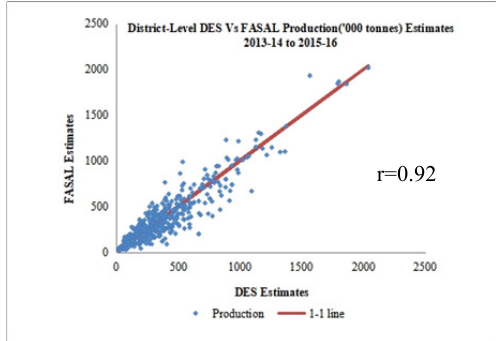
Figure 12. District-wise Production ('000 tonnes), DES and FASAL Estimates (2013-14 to